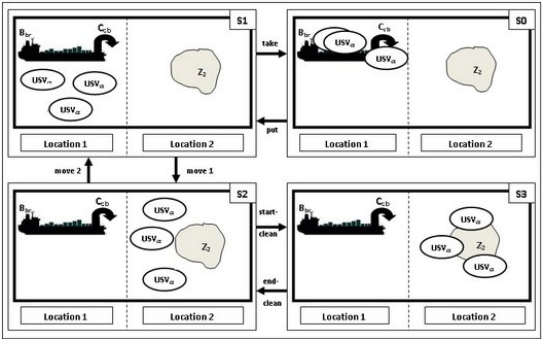
Figure 11: A state transition system for the SUSV-C domain.